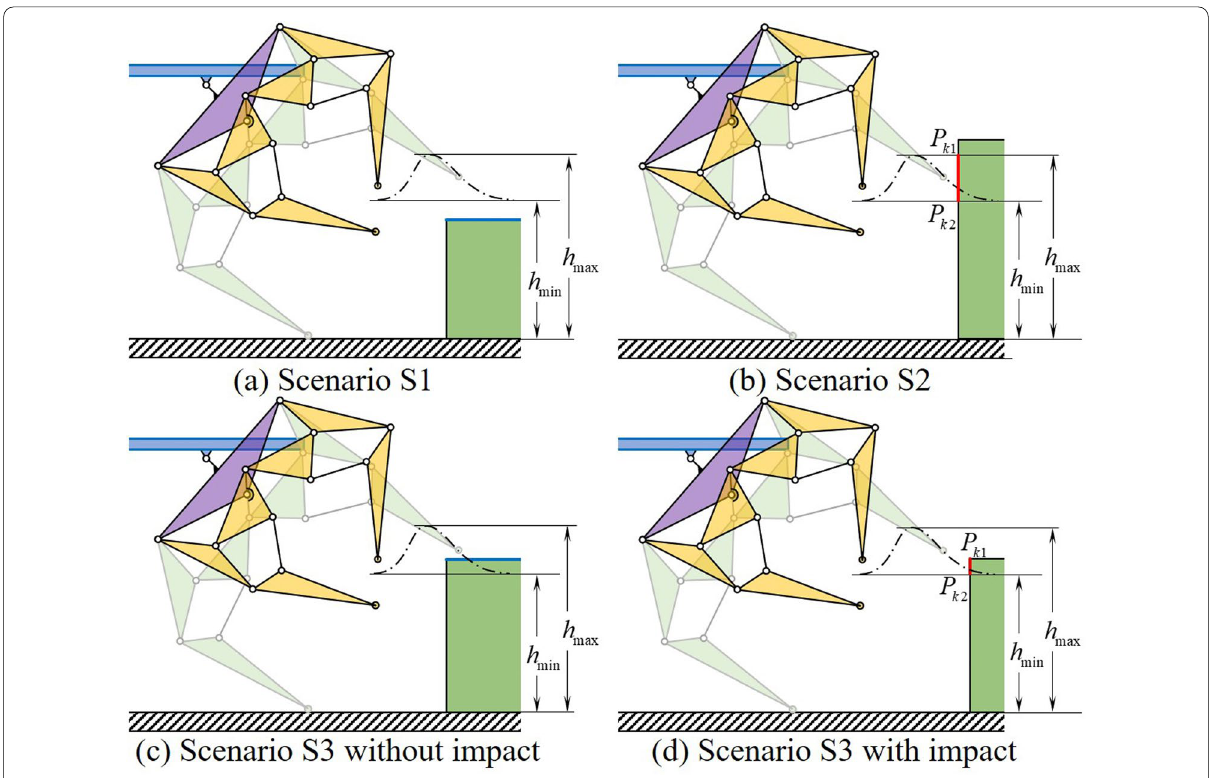
Figure 12 Scenarios in State 1 and State